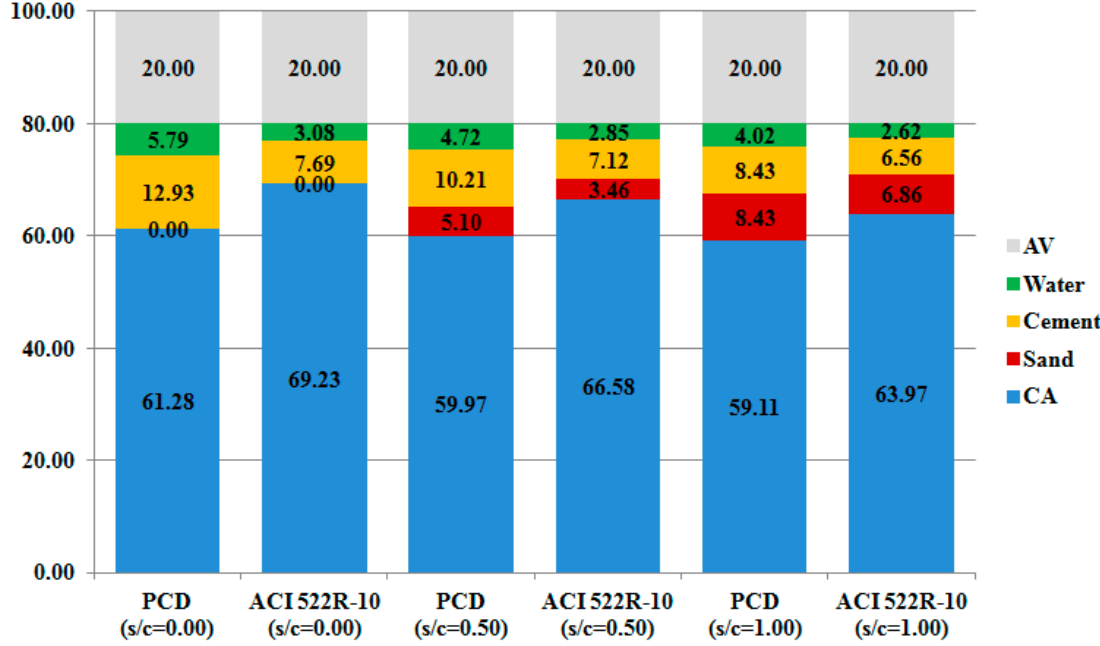
Figure 2. ACI 522R-10 and PCD methodologies dosages according to the s/c.